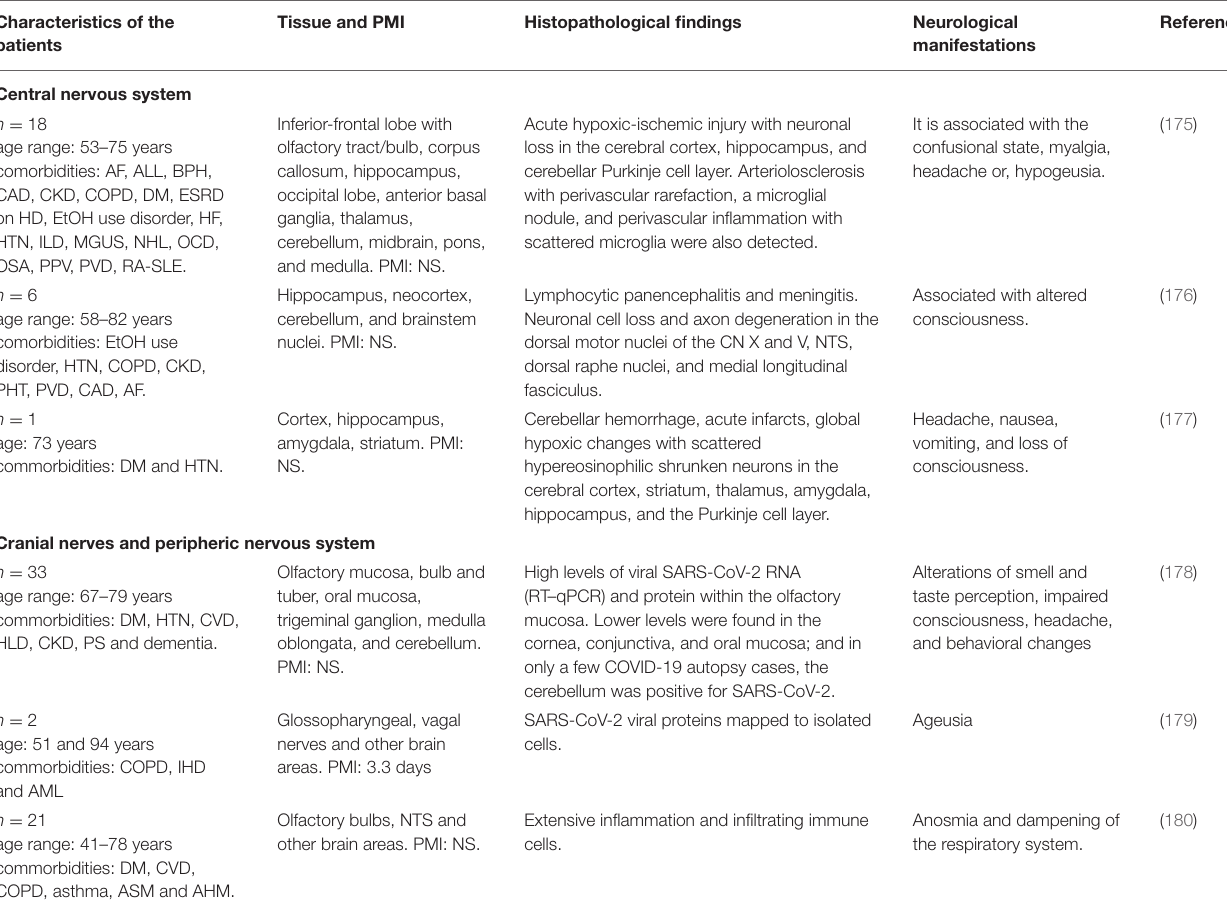
TABLE 4 | Neurohistopathological findings in patients infected with SARS-CoV-2 and their association with neurological